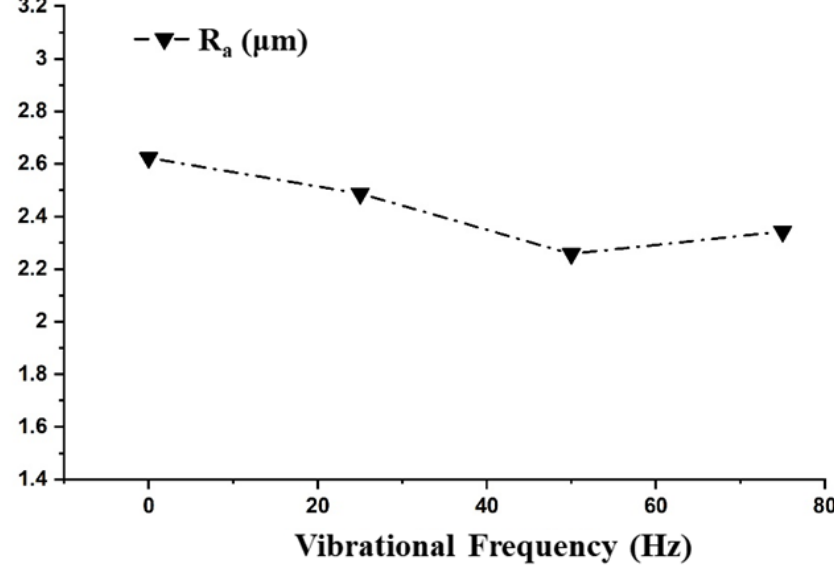
Figure 6. Effect of the Vibrational Frequency on the Responses.